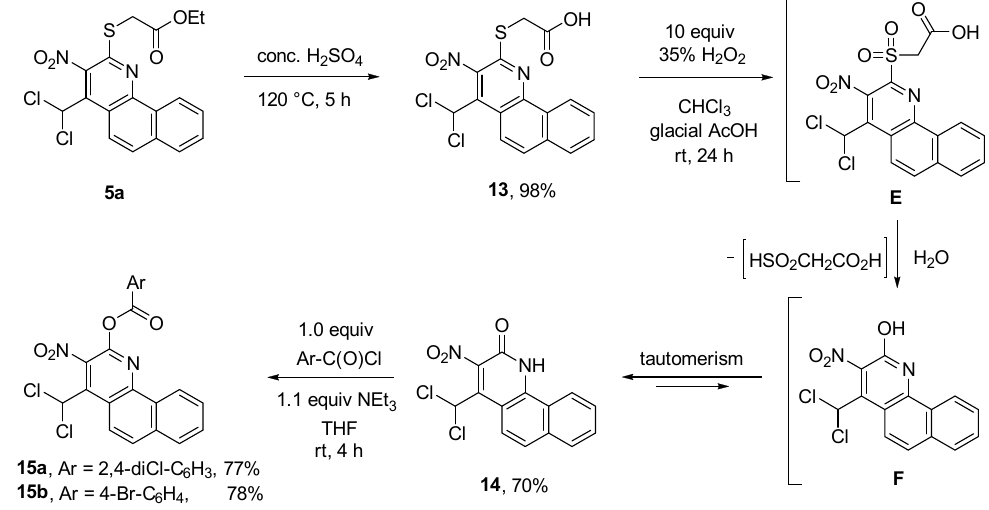
7 of 21 Figure 4. X-ray single-crystal structure of 4-(4-(dichloromethyl)-3-nitrobenzo[ h ]quinolin-2-yl)mor- pholine ( 11b ). Another method to modify compound 5a is the almost quantitative acidic cleavage of its ester group to 2-((4-(dichloromethyl)-3-nitrobenzo[ h ]quinolin-2-yl)thio)acetic acid ( 13 ). This molecule deserves interest because of its high activity against